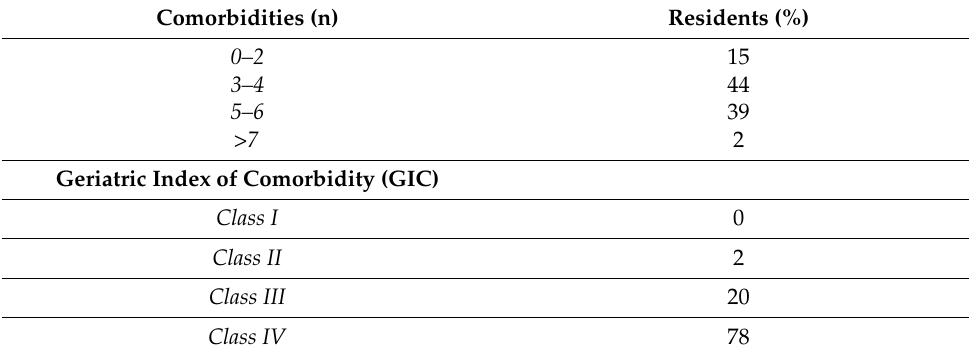
Table 2. Number of comorbidities and Geriatric Index of Comorbidity (GIC).